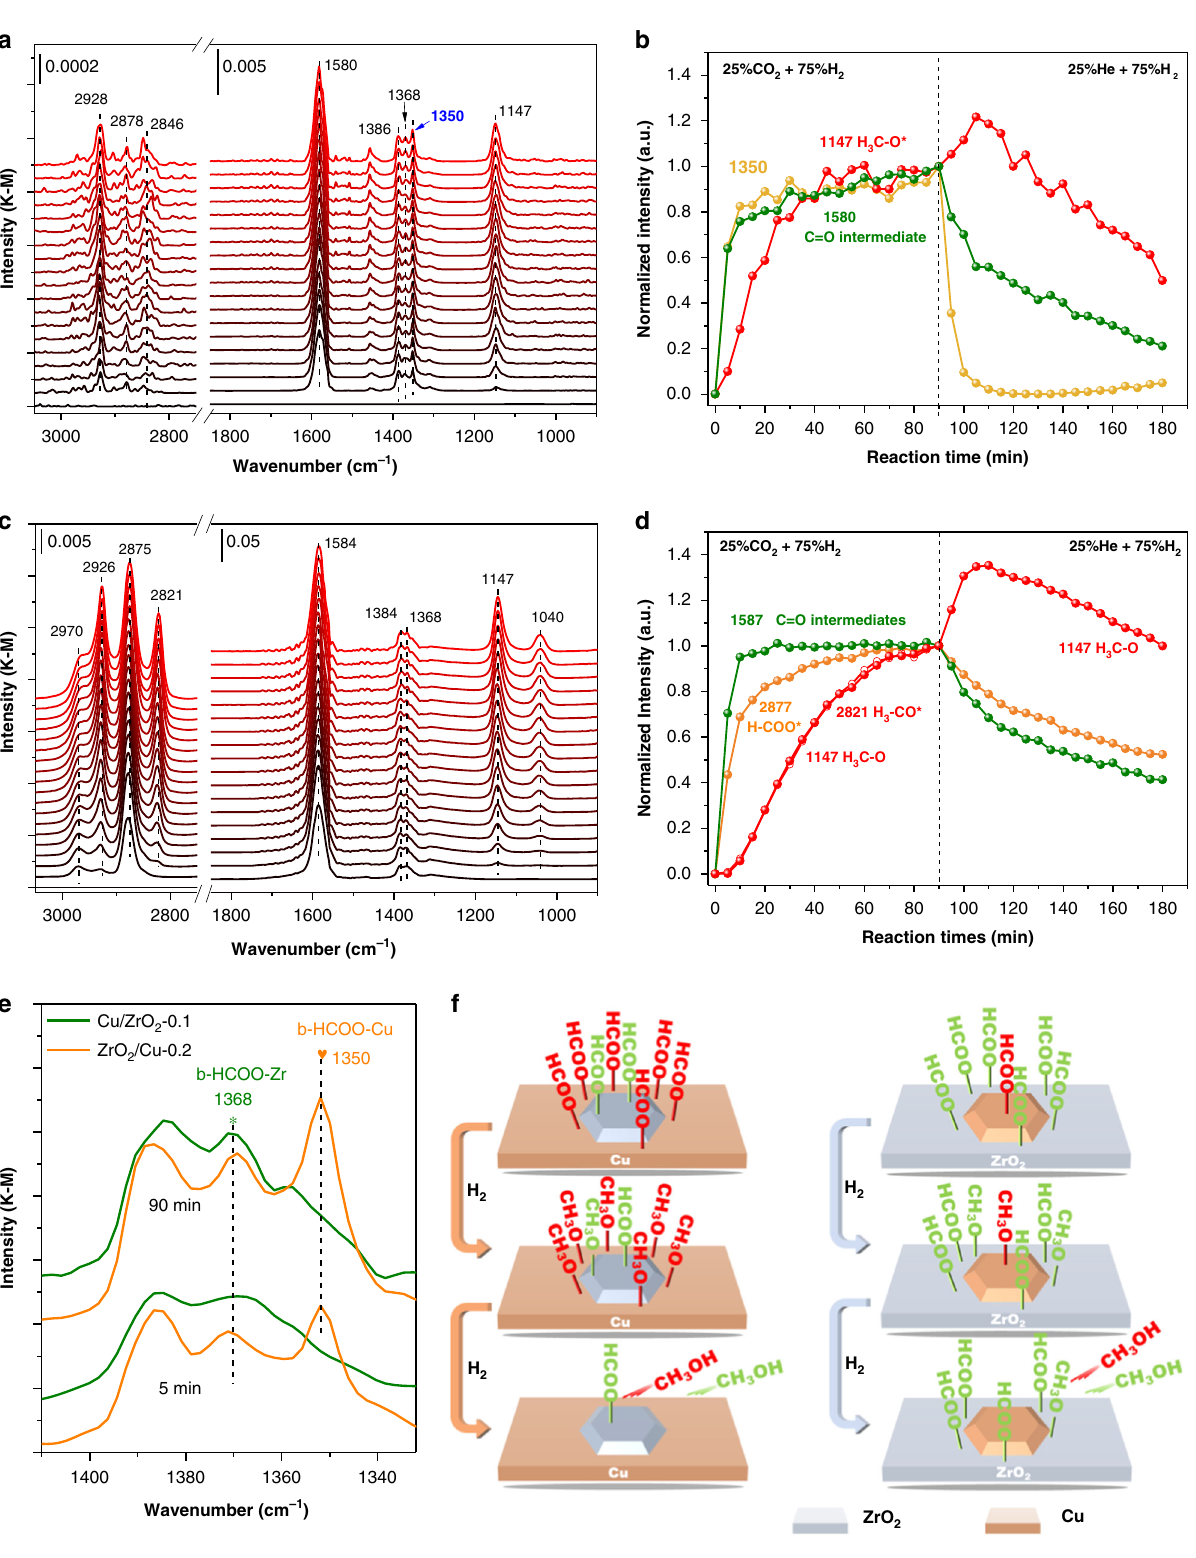
(Fig. 6e) based on the calculated adsorption free energy ( − 0.27 eV vs 0.21 eV). The probability distribution of different adsorption con fi gurations at 500 K were calculated by P plementary Table 4). These stable adsorption con fi gurations on Cu/ ZrO 2 and inverse ZrO 2 /Cu can further convert into the